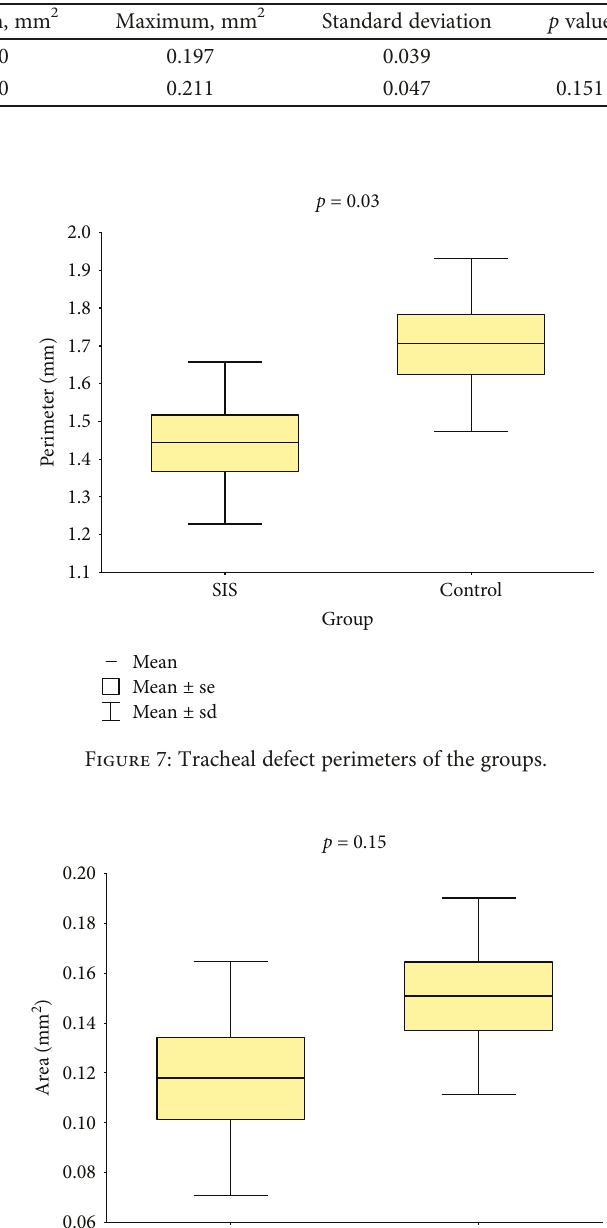
Table 2: Tracheal defect area: comparison between groups.